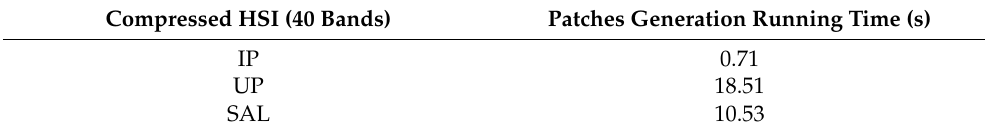
To take advantage of the spatial correlation feature extraction of the 3DCNN model, it is necessary to generate a patch with the pixel of interest and its neighbors to train and test the DL model. Each patch P is composed of 361 pixels ( P ∈ R 19 × 19 × bands ), with the pixel of interest in the center ( p 9,9, i ); if this pixel is associated with a background label, the patch is 3 discarded. The patch is padded with zeros if the pixel is at the edge of the image. Note that the labeled patches contain unlabeled pixels. In Table 8, the running time for patch generation is shown. Table 8. Running time for patch generation.